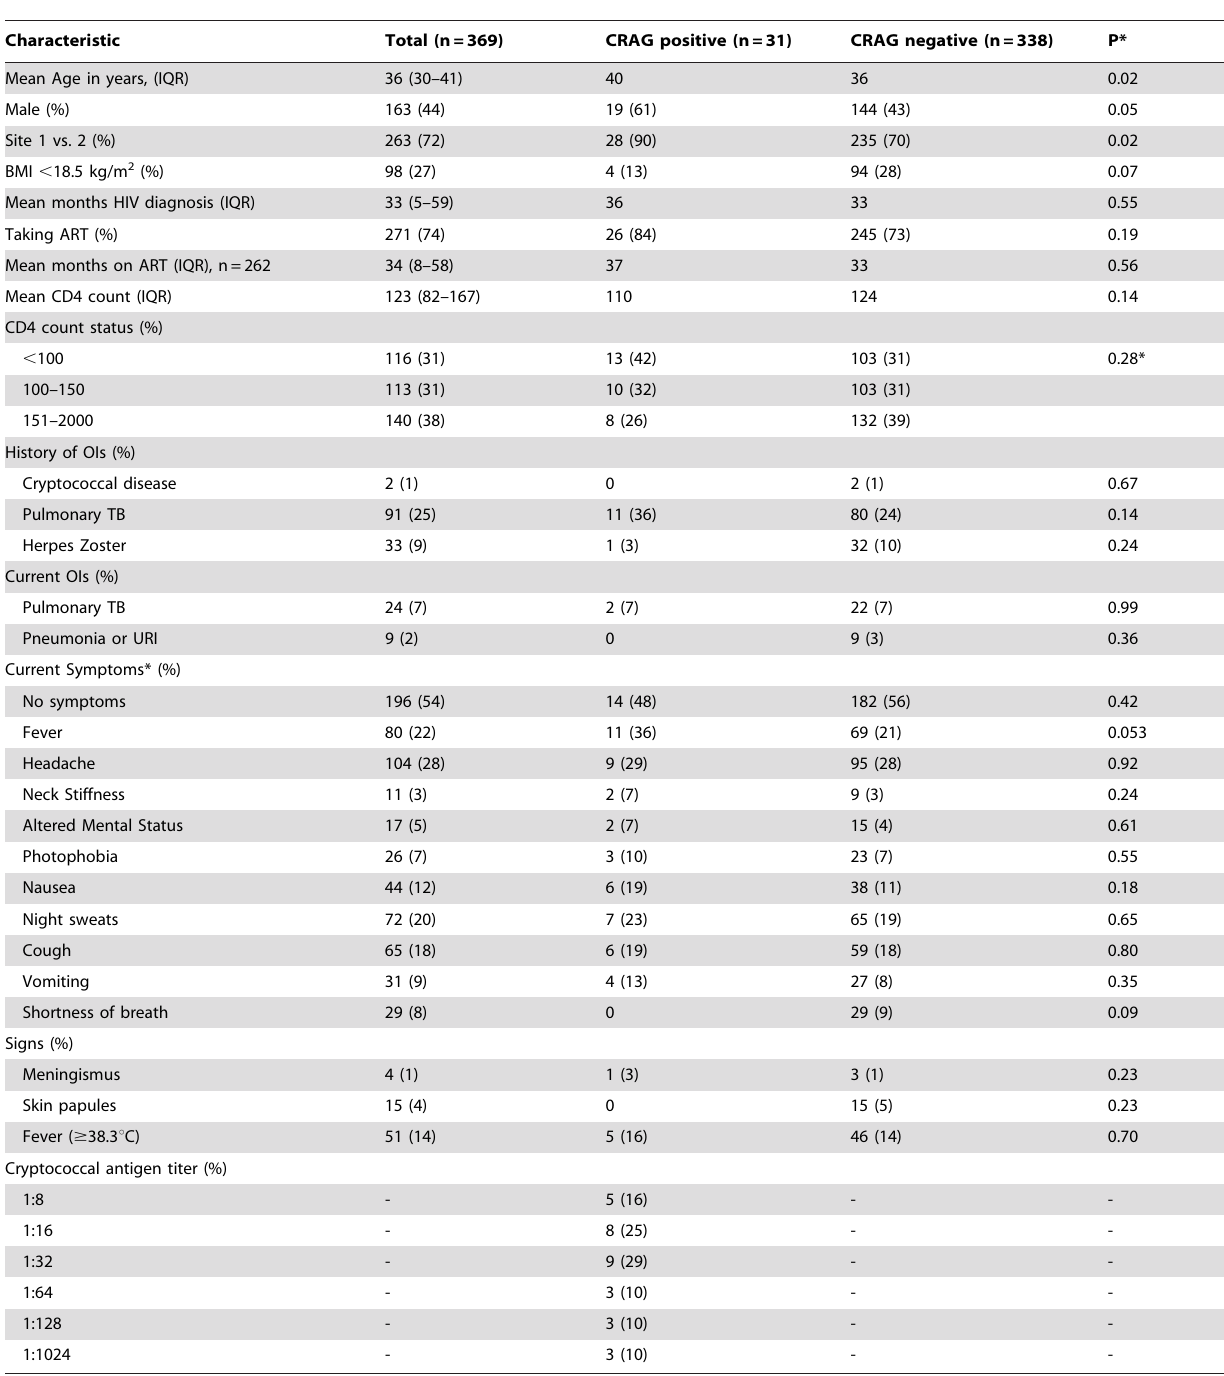
*Based on patient self-report; CRAG, serum cryptococcal antigen; BMI, body mass index; ART, antiretroviral therapy; OI, opportunistic infection; TB, tuberculosis; URI, upper respiratory infection acid; + ANOVA Statistic. doi:10.1371/journal.pone.0058377.t001 Patients with cryptococcal disease had a higher prevalence of fever than those with a negative test for cryptococcal disease but the difference did not reach statistical significance in univariate analysis (11/31 [36%] vs. 69/338 [21%], OR = 2.14, 95% CI 0.98–4.67, p = 0.06). In univariate analysis, there were no